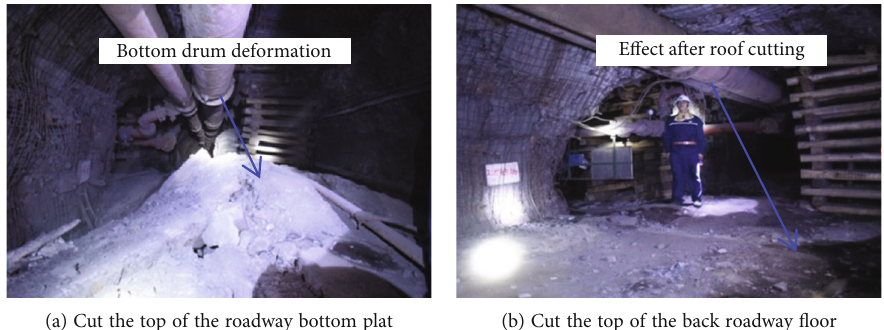
Figure 15: Deformation site of the bottom drum along the empty roadway before and after the cutting of the